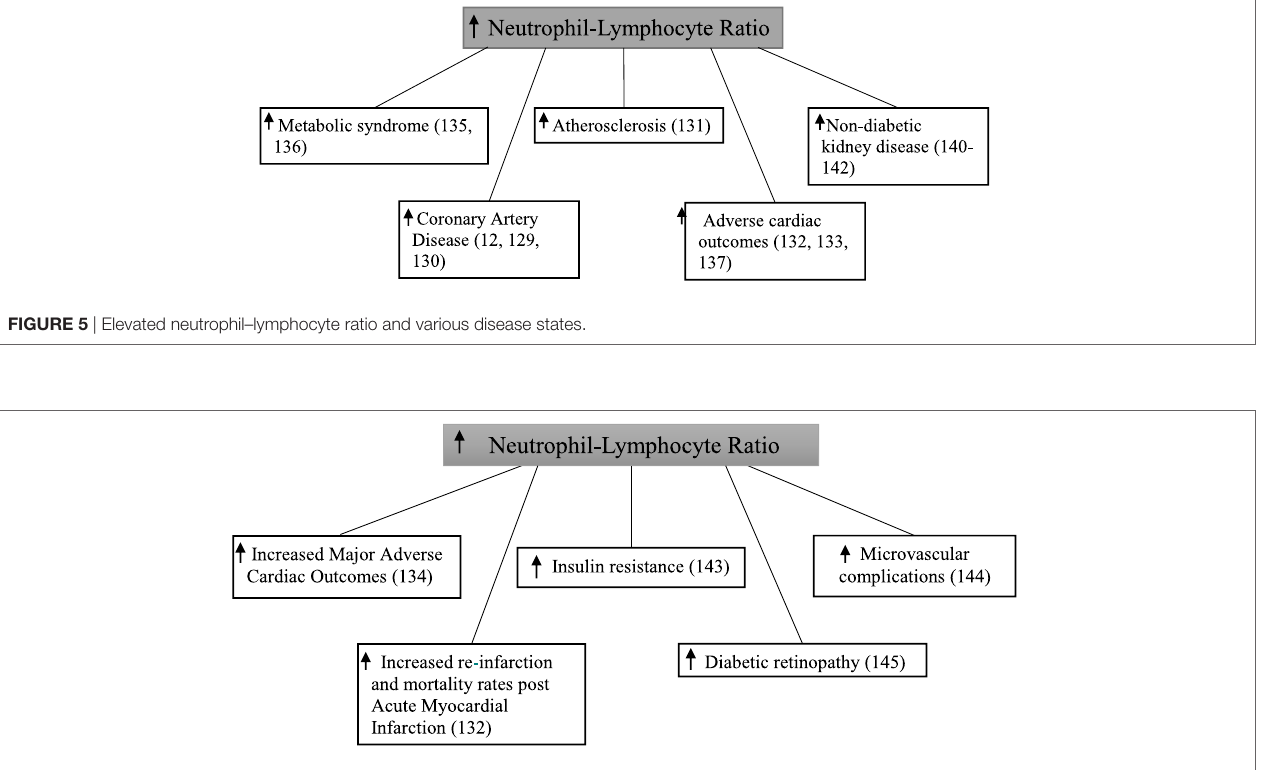
FiGURe 6 | Increased neutrophil–lymphocyte ratio and complications in diabetes mellitus.